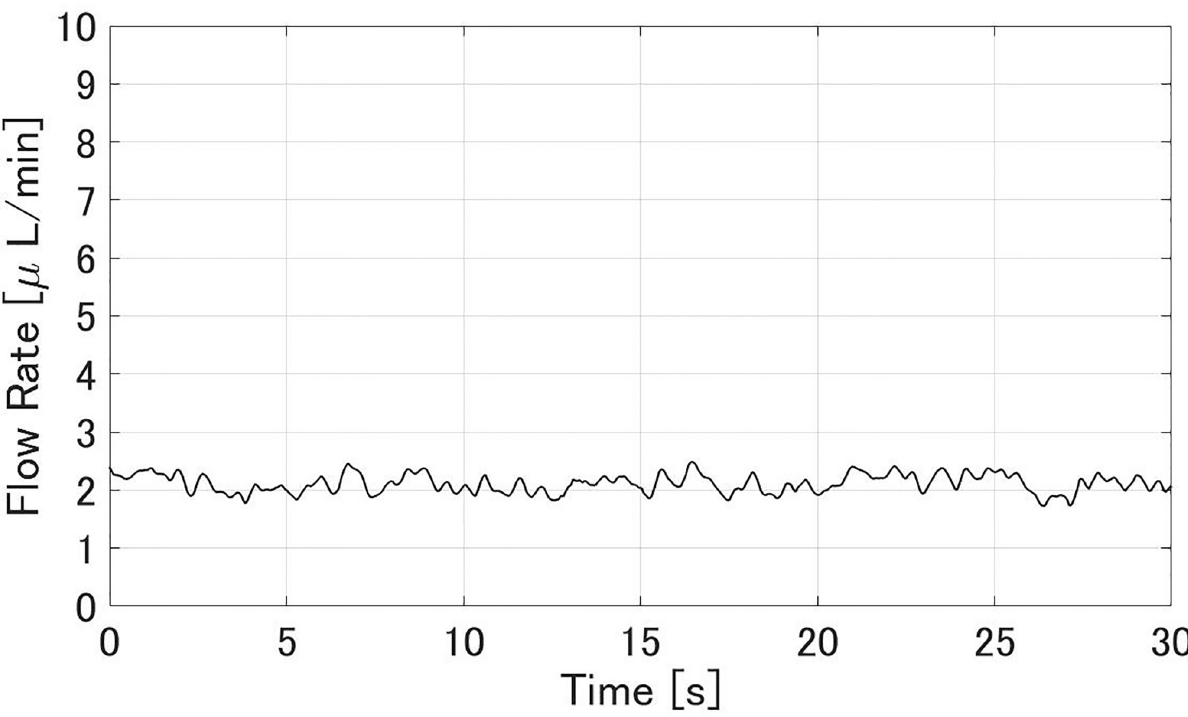
Fig 8. An experimental result of the flow rate Q when simulating glaucoma. The sampling interval was 0.07 s. Q was 2.1 ± 0.4 μ L/min.